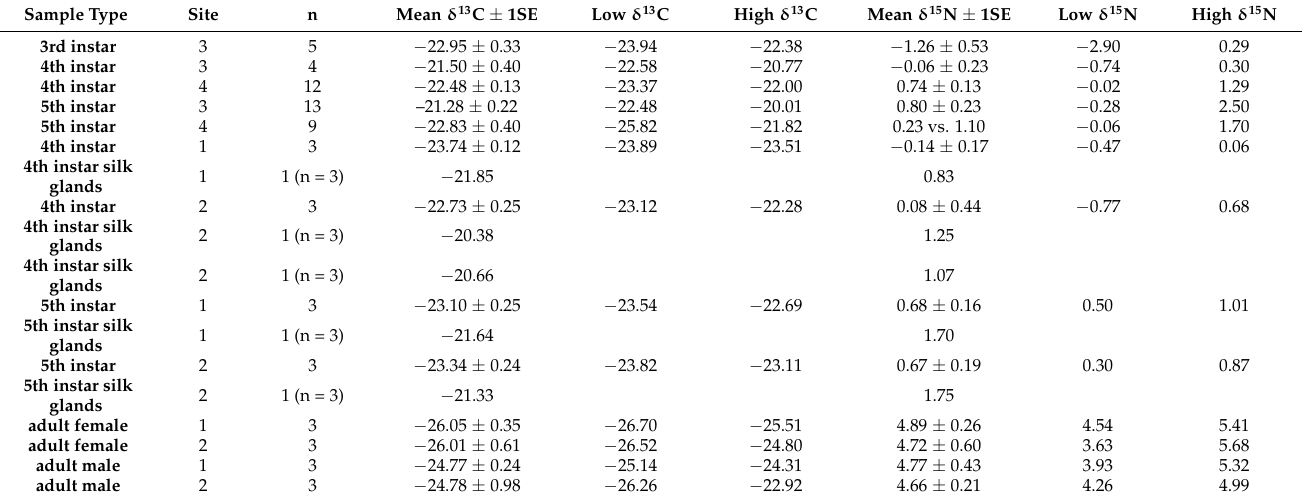
Table 2. Sample sizes, means, standard errors, and data ranges from stable isotope analyses.